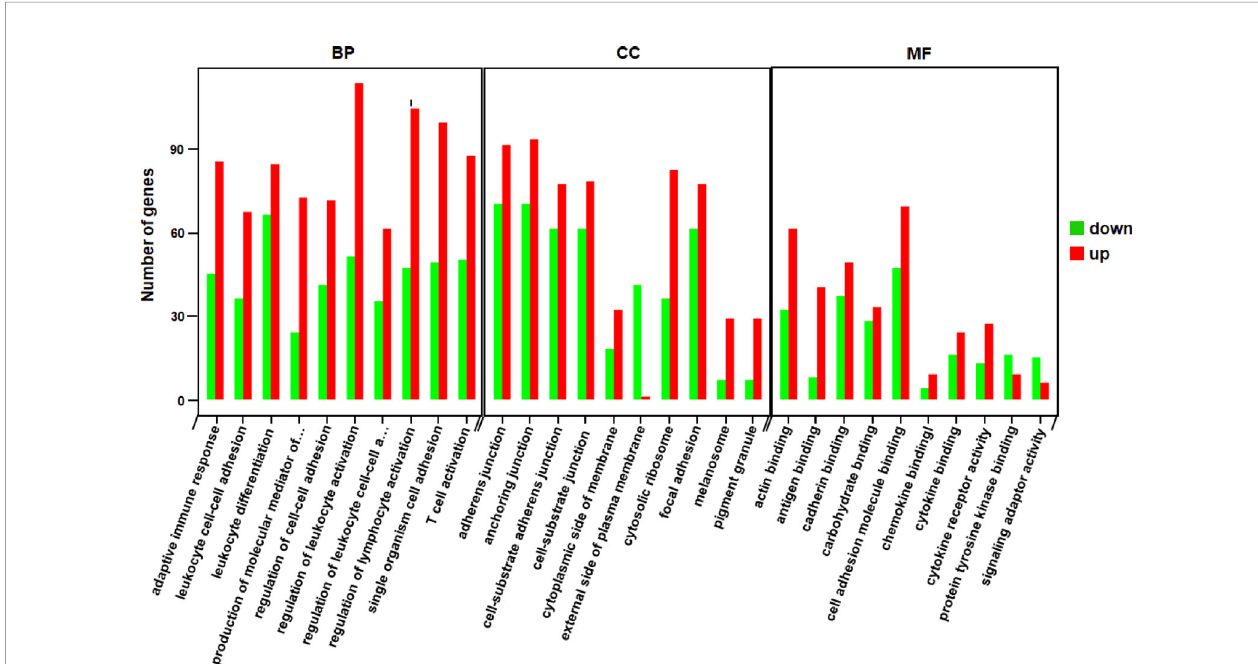
FIGURE 3 | Functional GO categories of DEGs (KO vs WT). The red bars represented the number of genes that were up-regulated in KO compared to WT, while the green bars represented the number of genes that were down-regulated. BP, biological process; CC, cellular component; MF, molecular function.